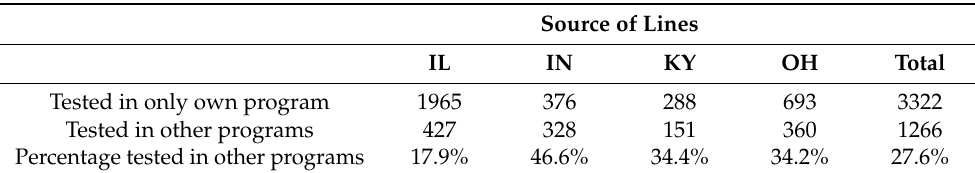
Table 7. Distribution of stage-1 and stage-2 lines from four programs (IL, IN, KY, OH) across testing sites of the four programs for the 2020–2021 season.